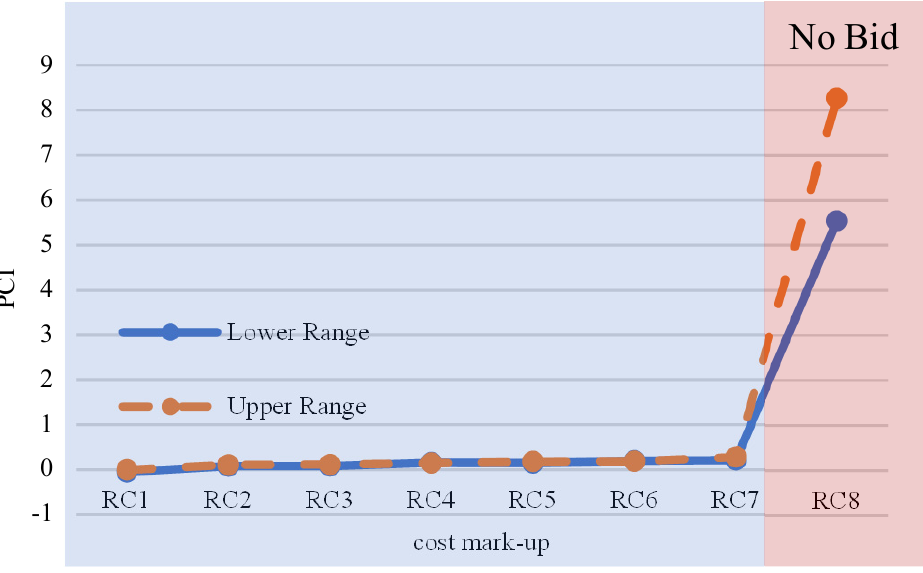
Figure 5. The no-bid area based on the analyzed data.